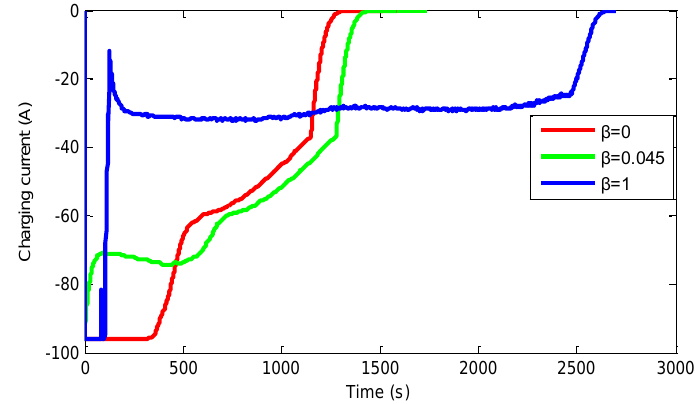
Figure 5. The dynamic property of charging current with different β.